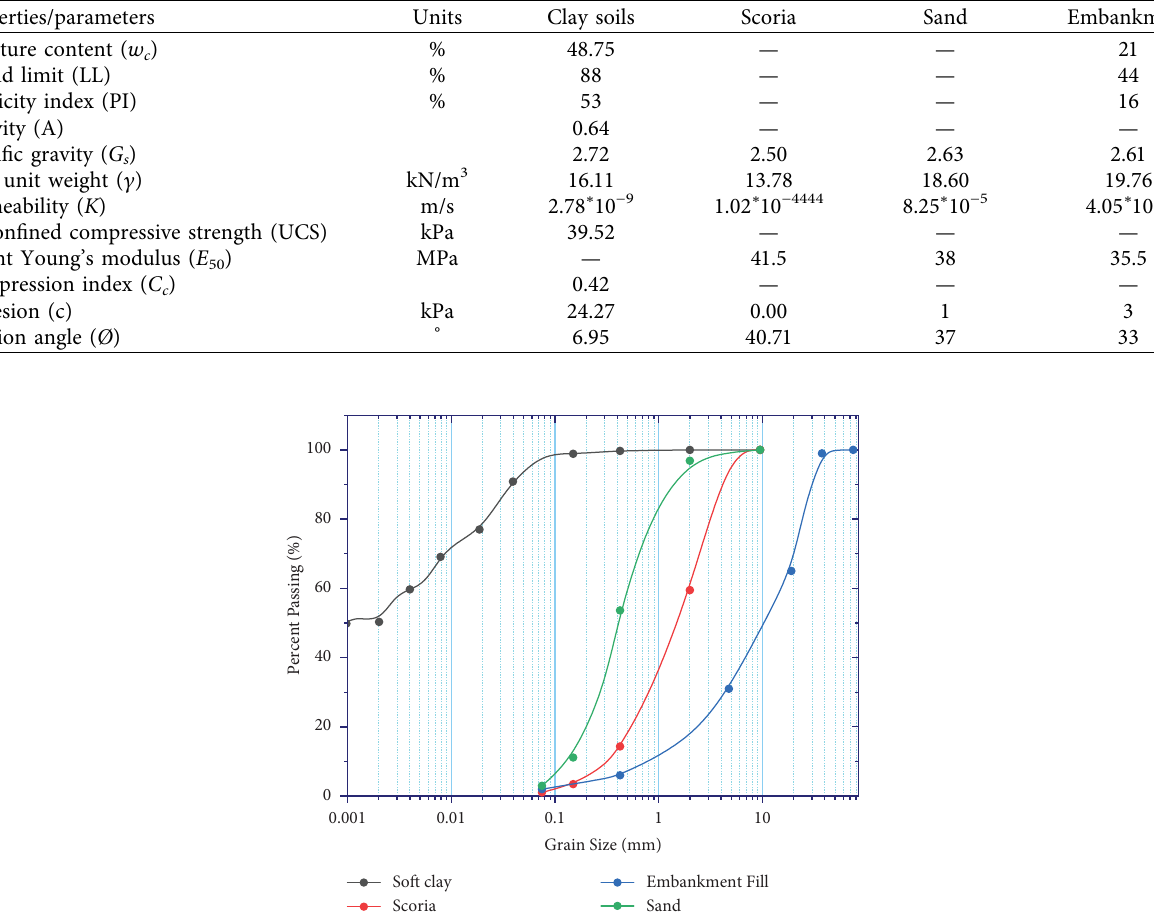
Table 1: Physical properties of the materials required.